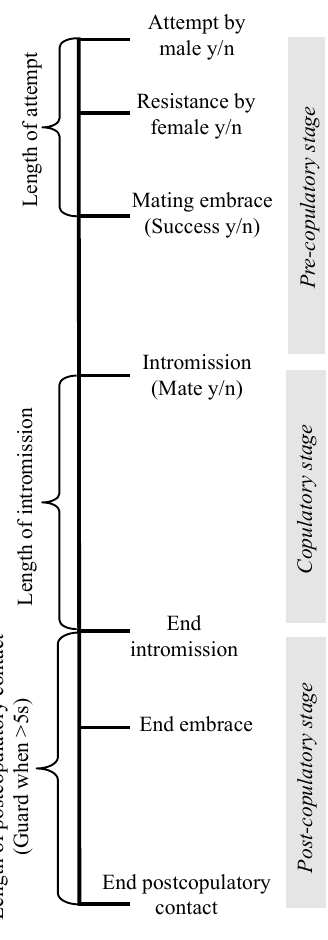
Figure 2. Timeline of behaviors during precopulatory, copulatory, and postcopulatory stages of mating interactions in leiobunine harvestmen. All of the behaviors measured are indicated in the order in which they occur on the timeline. The outcomes of each stage include: male attempt, yes or no (y/n); female resistance, yes or no; intromission (mating), yes or no; and postcopulatory guarding, yes or no.